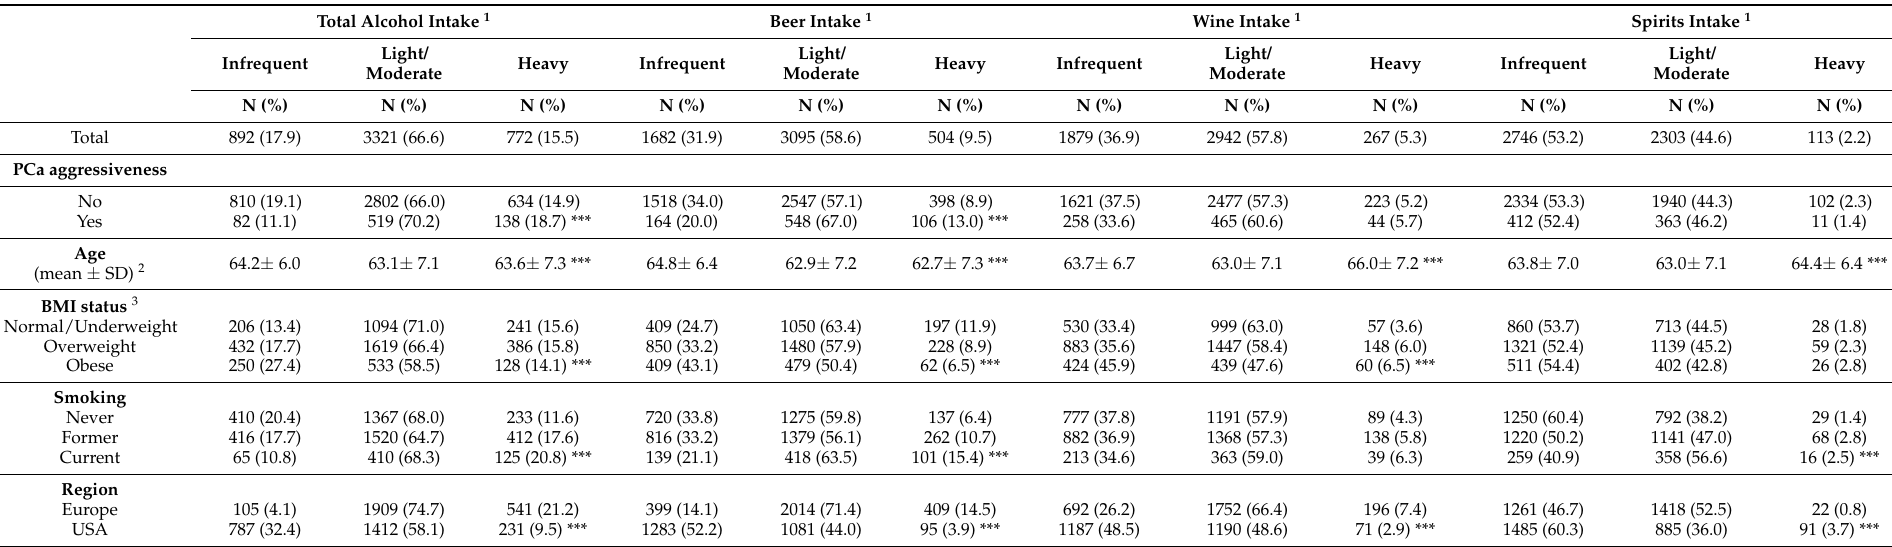
Table 2. Demographic and related characteristics by alcohol intake status for prostate cancer (PCa) patients (N =